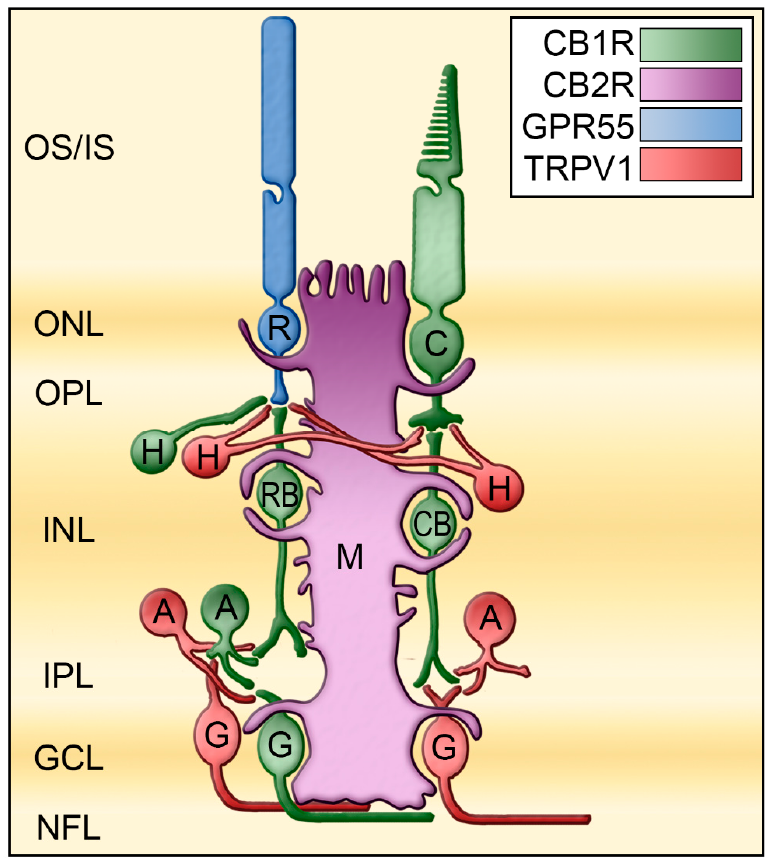
Figure 4. Mapping of the receptors CB1R, CB2R, GPR55, and TRPV1 in the monkey retina. These receptors are differently expressed in the retina of monkeys. These results are compiled from several published articles [16,27–29] . CB1R is represented in green, CB2R in magenta, GPR55 in blue, and TRPV1 in red. A, amacrine cells; C, cone photoreceptors; CB, cone bipolar cells; G, ganglion cells; GCL, ganglion cell layer; H, horizontal cells; INL, inner nuclear layer; IPL, inner plexiform layer; IS, photoreceptors inner segments; M, Müller cells; NFL, nerve fiber layer; ONL, outer nuclear layer; ONL, outer plexiform layer; OS, photoreceptors outer segments; R, rod photoreceptors; RB, rod bipolar cells. Redrawn from [27].